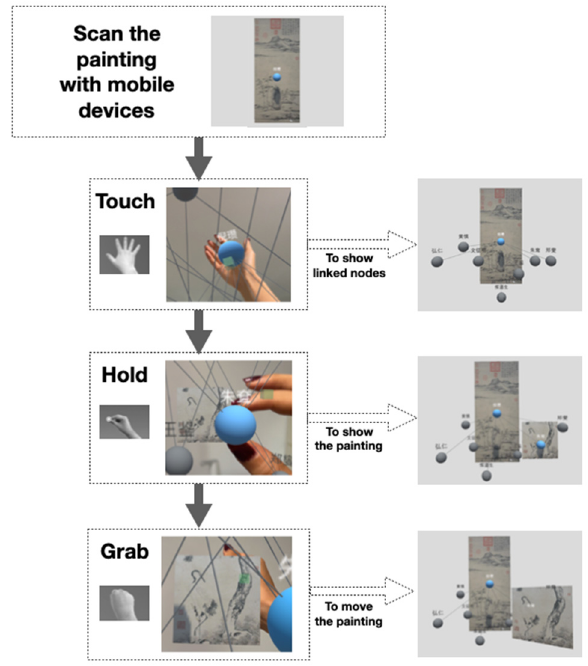
Figure 10. The interaction process with the iterated AR graph (the text on top of the nodes are the Chinese names of the painters).